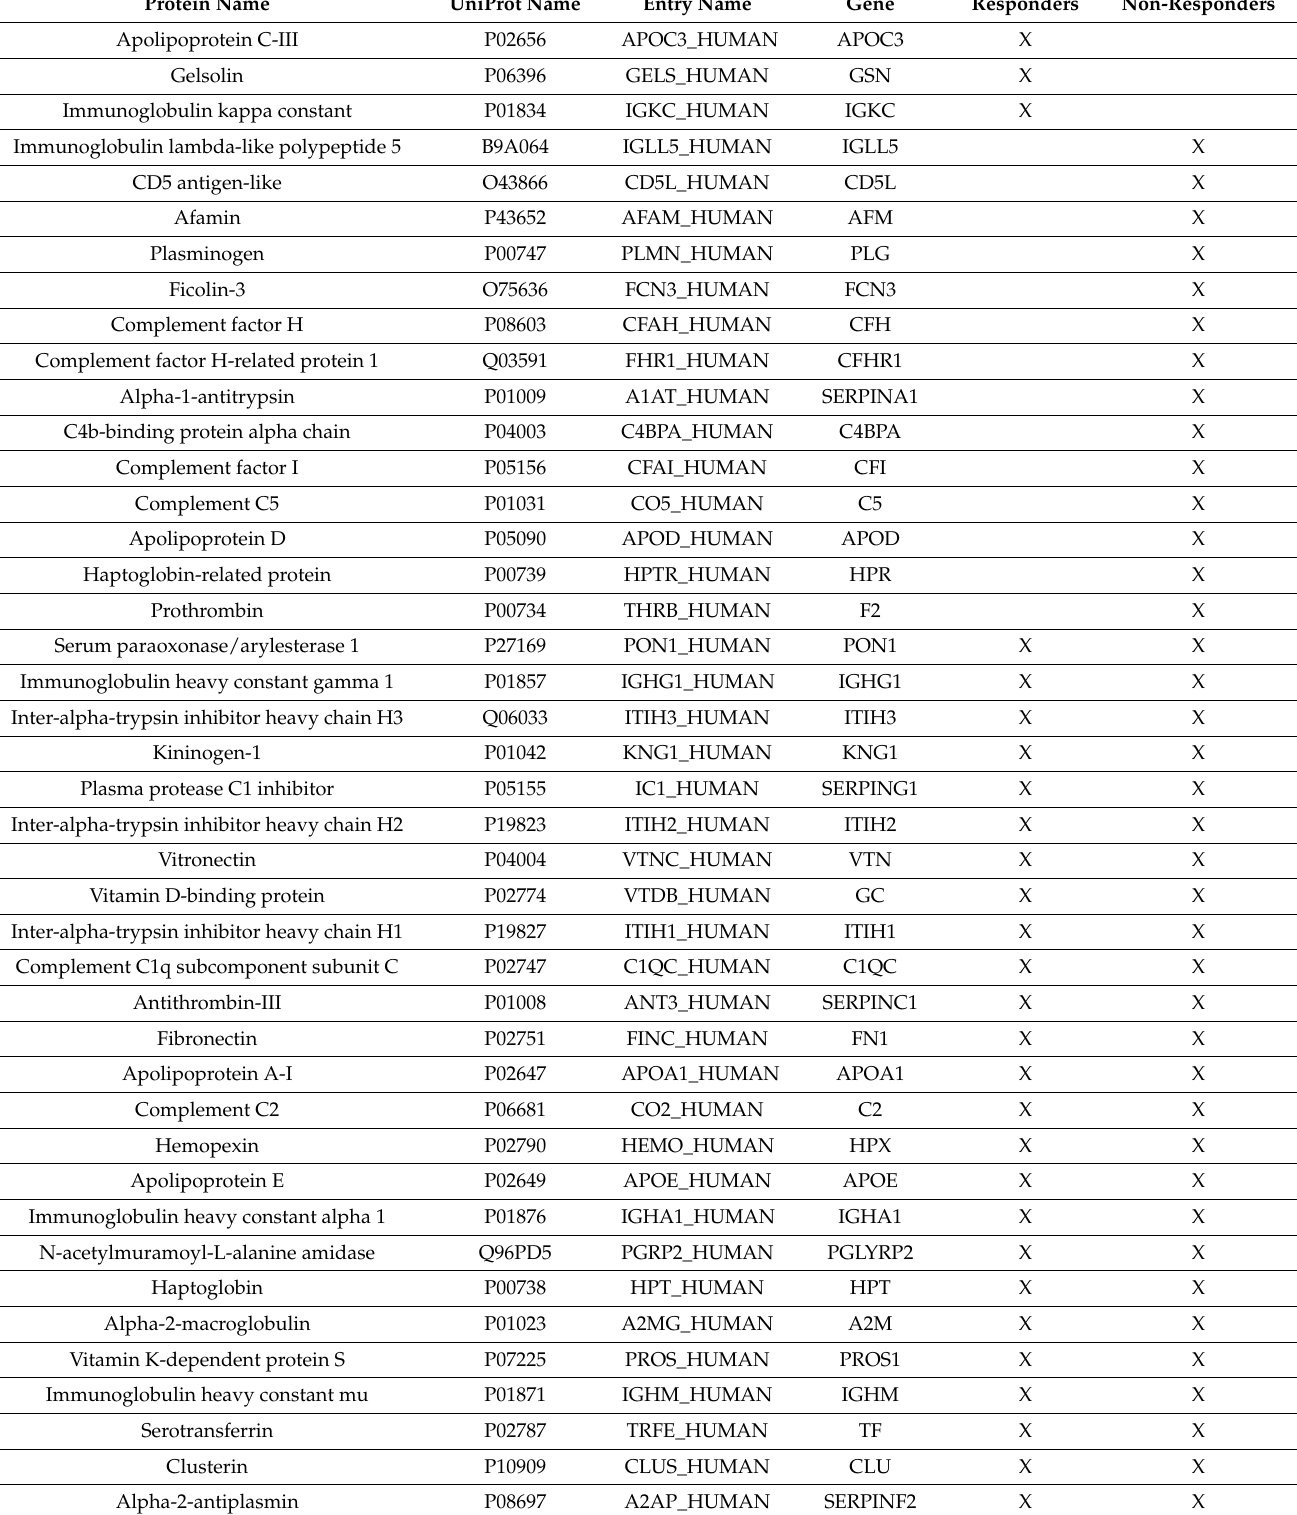
Table 3. Proteins commonly identified by the three different treatment methods of serum samples obtained from HER2-positive BC patients before NAC ( n = 6 responders, n = 4 non-responders) ( method 1: analysis of the crude serum; method 2: AuNPs-PC analysis; method 3: PtNPs-PC analysis). The accession number, gene name, and species (Human) were